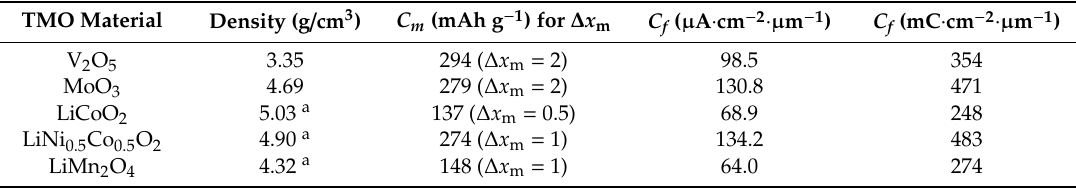
Table 4. Characteristics of the oxide materials used as a positive electrode in Li batteries. ∆ x m is the quantity of electrons transferred (or Li